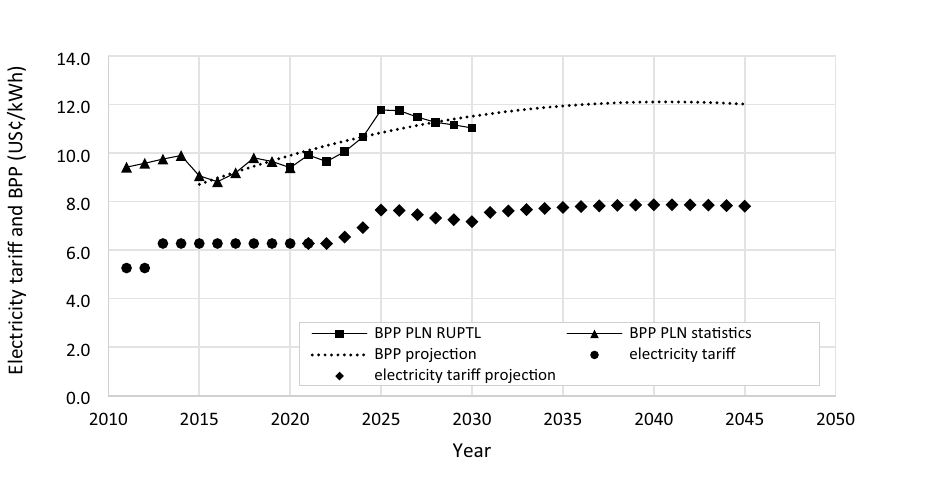
Figure 6. BPP and electricity tariff for case